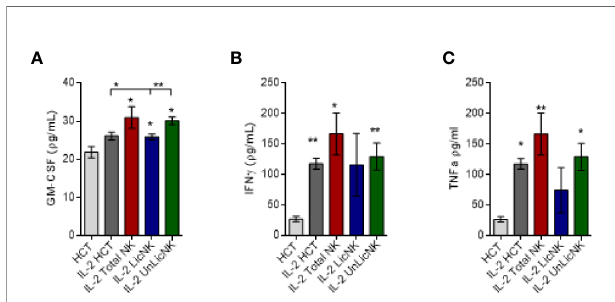
FIGURE 2 | Analysis of GM-CSF, IFN g and TNF a after NMAC HCT. Serums were collected form mice receiving NMAC HCT treatment regimen depicted in Figure 1A . and the cytokine levels were measured by a multiplex assay. (A – C) Levels of GM-CSF (A) , IFN g (B) , and TNF a (C) in the serum. Data is representative of two independent experiments with n=3 – 5 per group (mean ± SEM). One-way ANOVA or student t-test were used to assess signi fi cance. (*p<0.05, **p<0.01, ***p<0.001, n.s, no signi